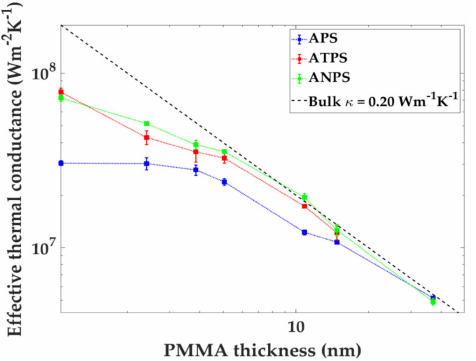
Figure 4. The e ff ective thermal conductance G eff of the PMMA layer as a function of PMMA thickness for APS, Au / Ni / PMMA / Si (ANPS) and Au / Ti / PMMA / Si (ATPS) samples. The dotted lines were added for clarity. Also shown here is the linear relation for bulk PMMA (dashed line). The error bars were calculated by the standard deviation error in the thermal measurements.